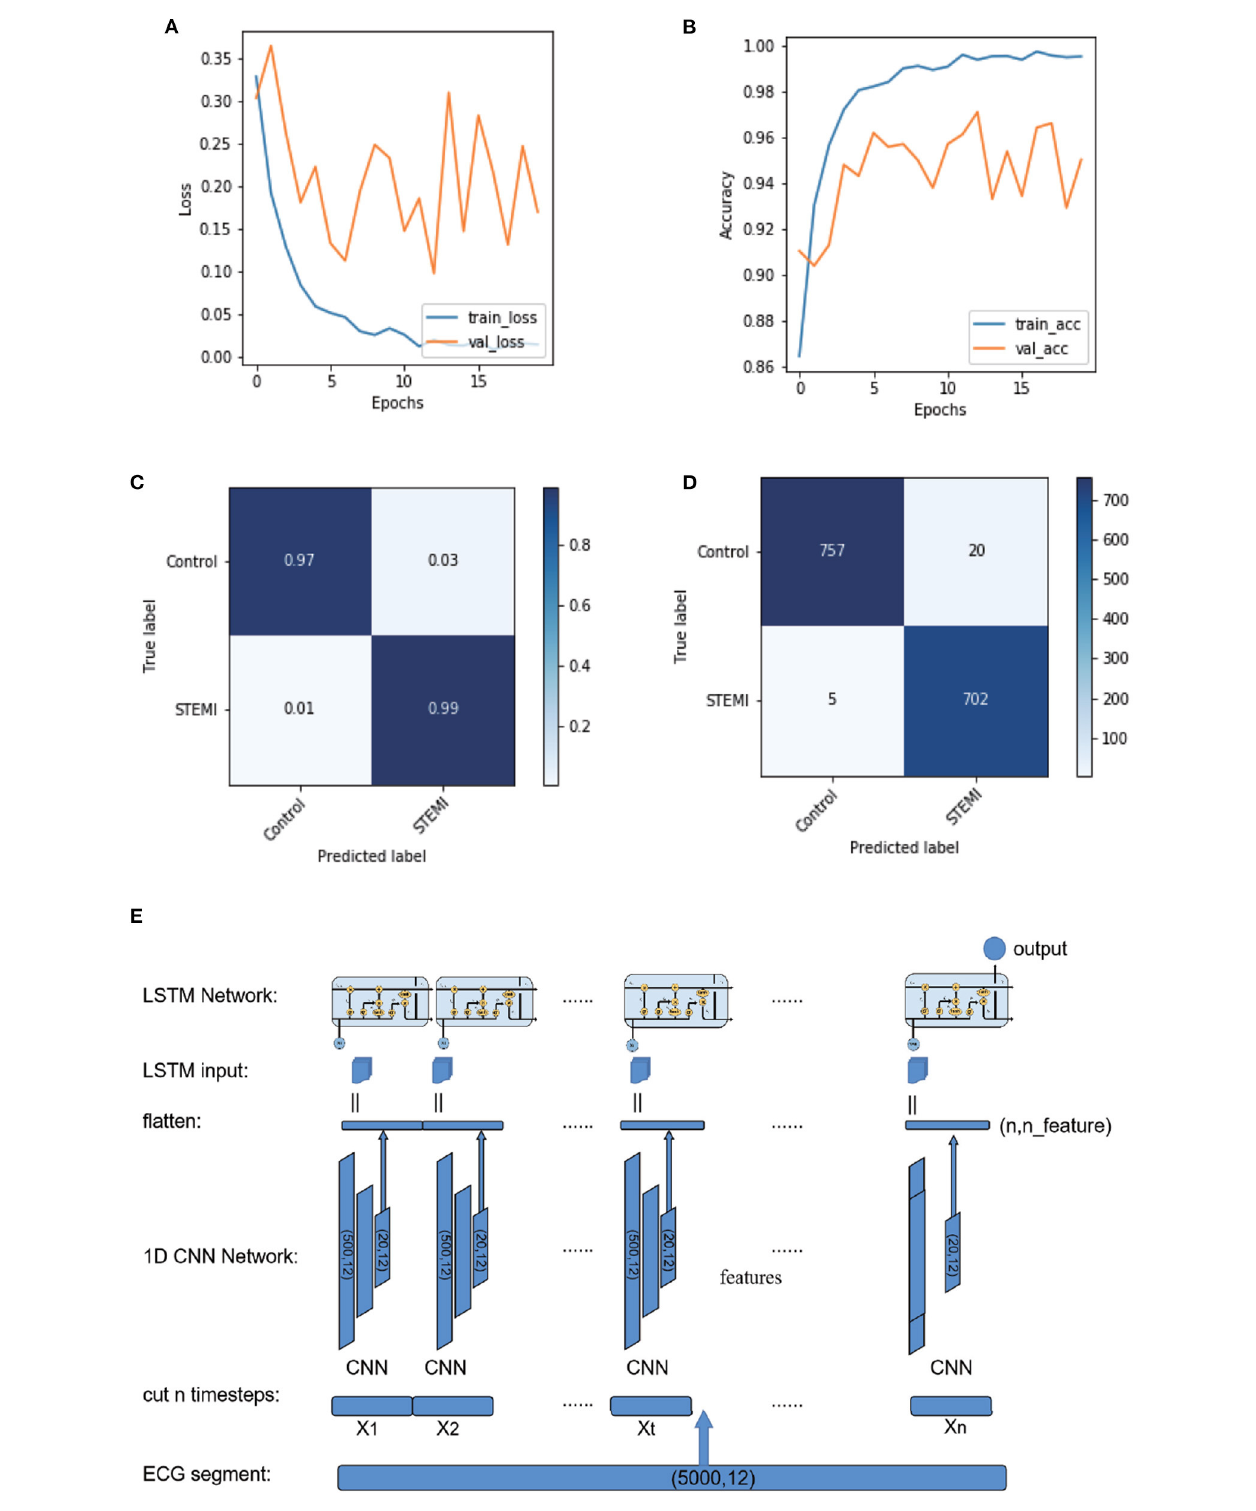
FIGURE 3 | Plot of logarithmic accuracy/loss for the training step of CNN-LSTM. Train and test accuracy/loss diagrams of the models. (A,B) Train and test accuracy/loss diagrams of the optimum result on the CNN-LSMT model. (C,D) Confusion matrices for predicting control and STEMI using the CNN-LSTM model in the test dataset. (E) Schematic of the CNN-LSTM